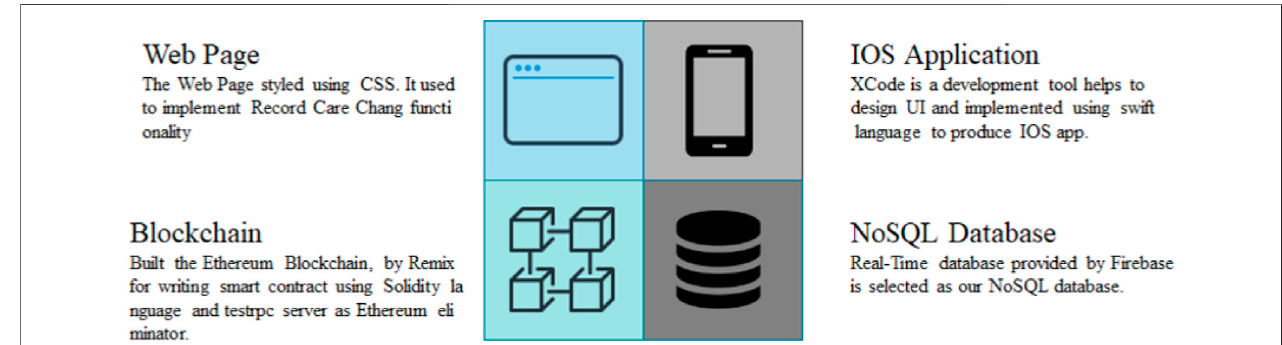
FIGURE 8 | Off-chain and on-chain components.